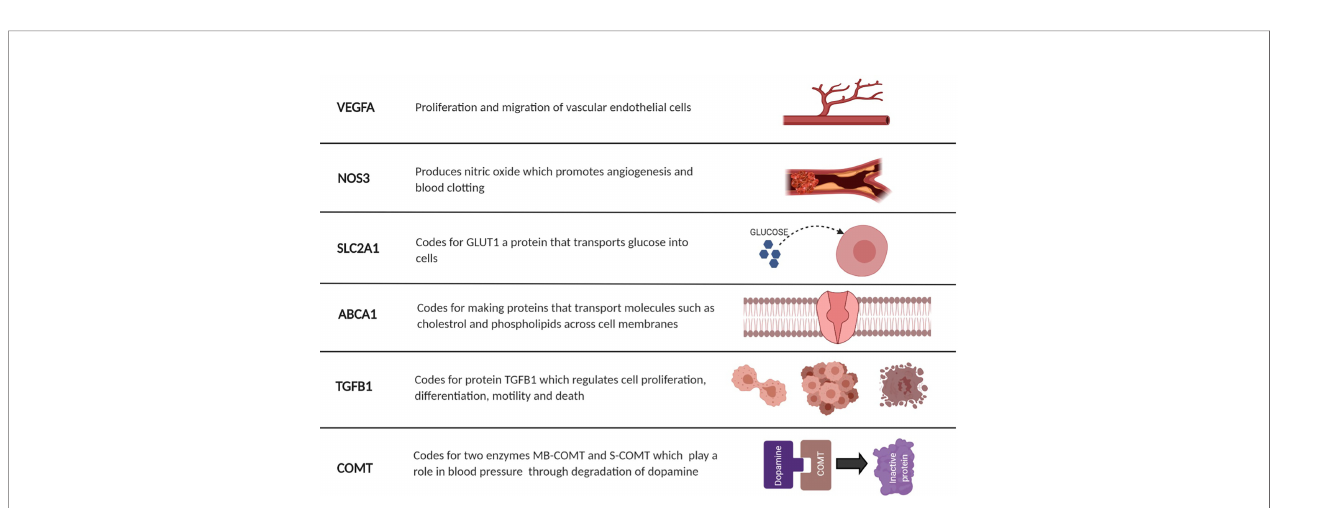
FIGURE 2 | Illustrative fi gure summarizing the role each of gene and potential complications. SLC2A1, Solute Carrier Family 2 Member 1; VEGFA, Vascular endothelial growth factor A; NOS3, Nitric Oxide Synthase 3; ABCA1, ATP Binding Cassette Subfamily A Member 1; TGFB1, Transforming Growth Factor Beta 1; COMT, Catechol-O-methyltransferase. Created with